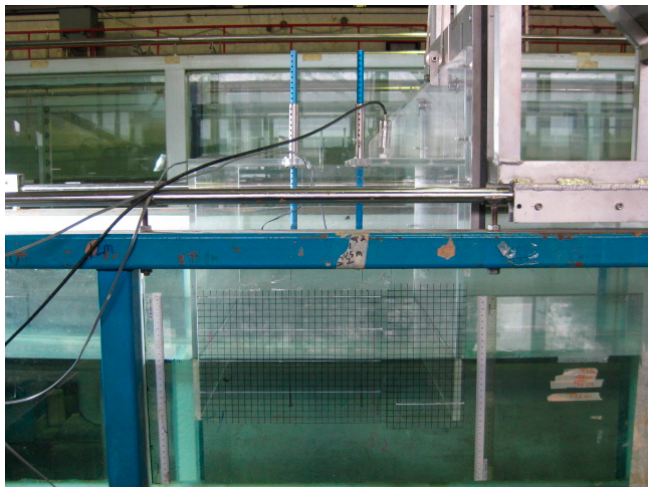
Figure 2. A photo of the OWC model tested in the present study.